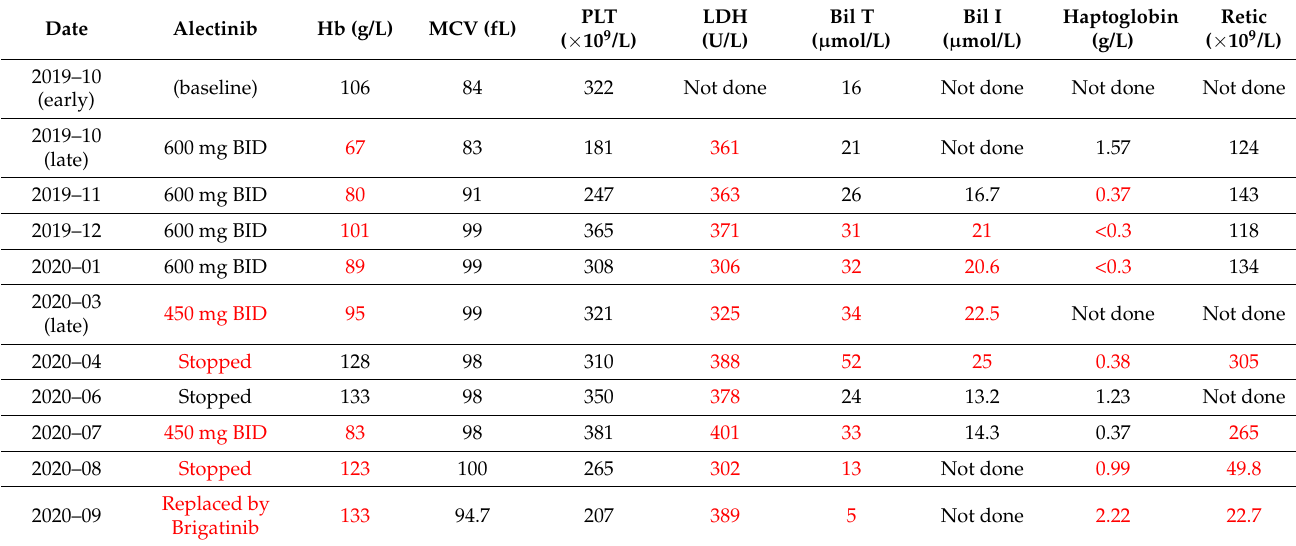
Table 1. Variations in hematologic profile in patient 2 with initiation, interruption, rechallenge and discontinuation of